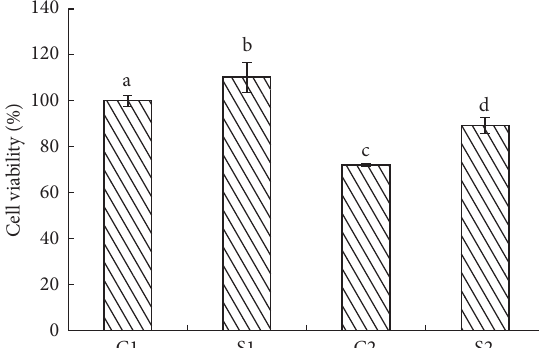
Figure 2: Viability of Caco-2 cells after different treatment as follows: medium treatment without H 2 O 2 and peptide (control 1: C1), H 2 O 2 treated only (control 2: C2), peptide treated only (sample 1: S1), and medium treatment with H 2 O 2 and peptide (sample 2: S2). The viability of cells was expressed as a percentage of the viability of cells in C1 treatment. Results were the means ± SD from three independent experiments. Different small letters indicated significant differences between groups ( p < 0 . 05).